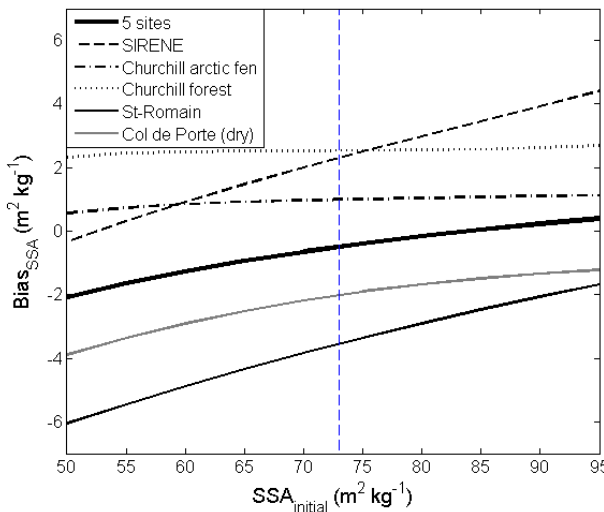
Fig. 8. Bias between the measured SSA and the simulated SSA us- ing CLASS-SSA as a function SSA initial (the vertical dotted blue line represents the SSA initial set in CLASS-SSA at 73.0m 2 kg − 1 ).